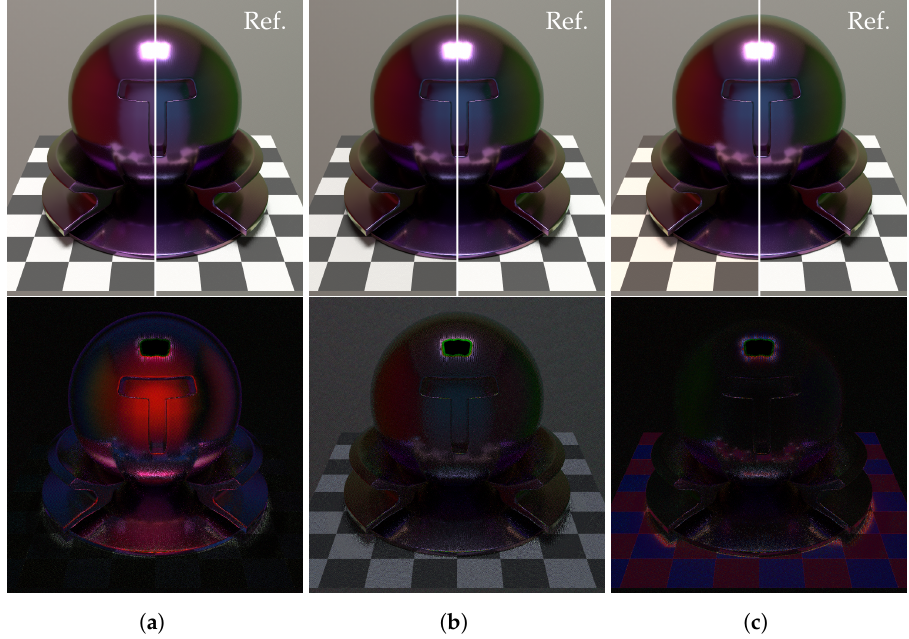
Figure 13. Results of rendering (D65). ( a ) RGB rendering. ( b ) PBRT renderer. ( c )